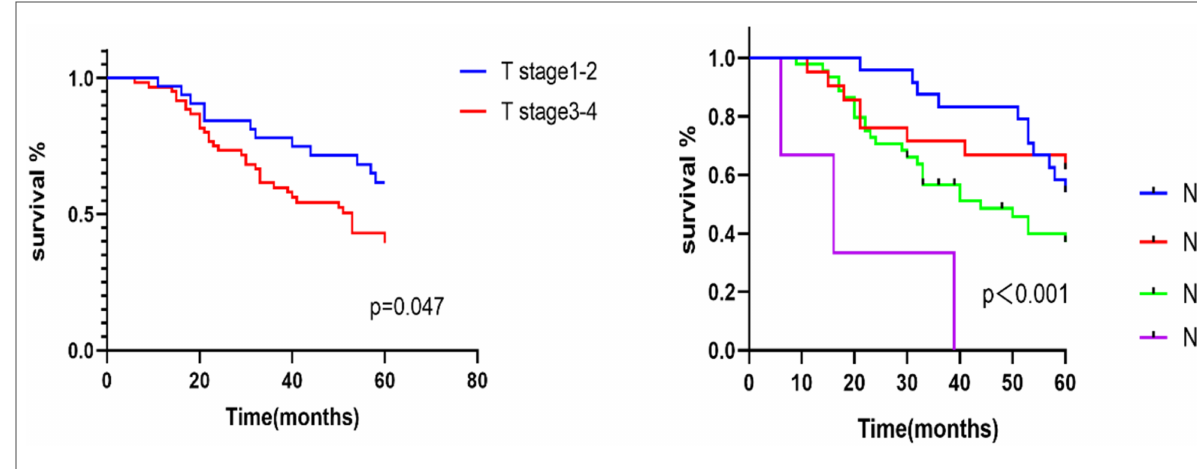
FIGURE 2 Kaplan-Meier survival curves for different T-stages and N-stages.